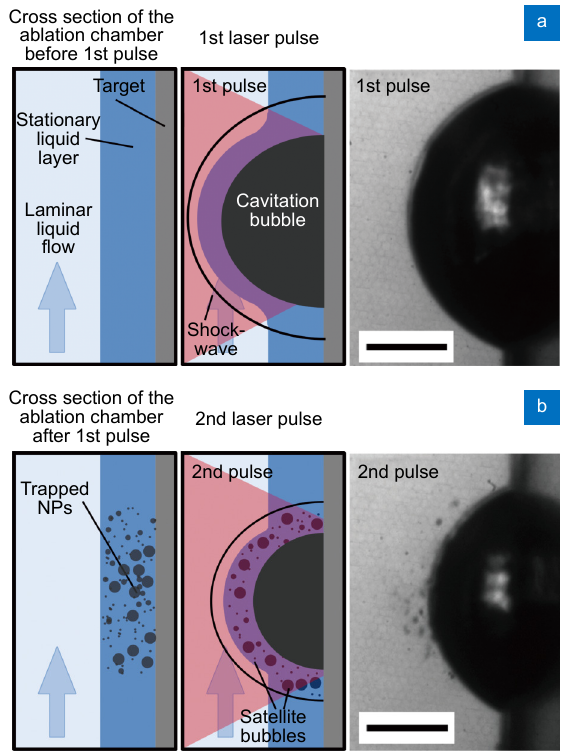
Fig. 5 | The sketches illustrate the stationary liquid layer above the target and the first cavitation bubble of an image sequence ( a ). The formed NP are partially trapped in the stationary layer leading to satellite bubble formation, as shown in the sketch, and observed ex- perimentally ( b ); please note that the sketches in the middle are not depicted on the correct time scale for the sake of the message, the scale bar measures 250